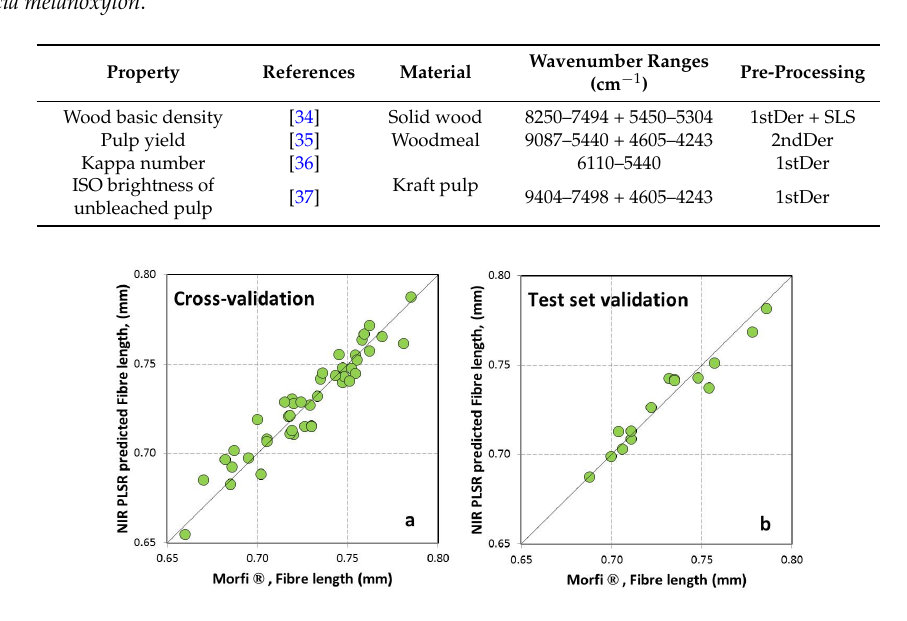
Table 3. Wavenumber ranges and pre ‐ processing used in the NIR ‐ PLS ‐ R (infrared ( NIR ) partial least squares regression ( PLSR ) models published in bibliography for different properties of Acacia melanoxylon .